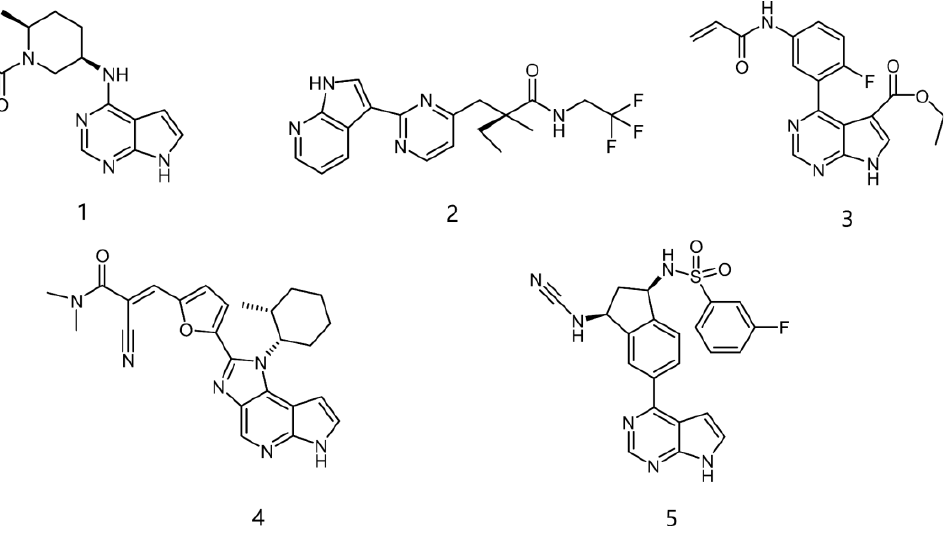
Figure 1. PF-06651600 [17] ( 1 ), a JAK3-specific inhibitor in clinical studies and recently reported JAK3 inhibitors [18] ( 2 – 4 ), PubChem CID 137321159 ( 5